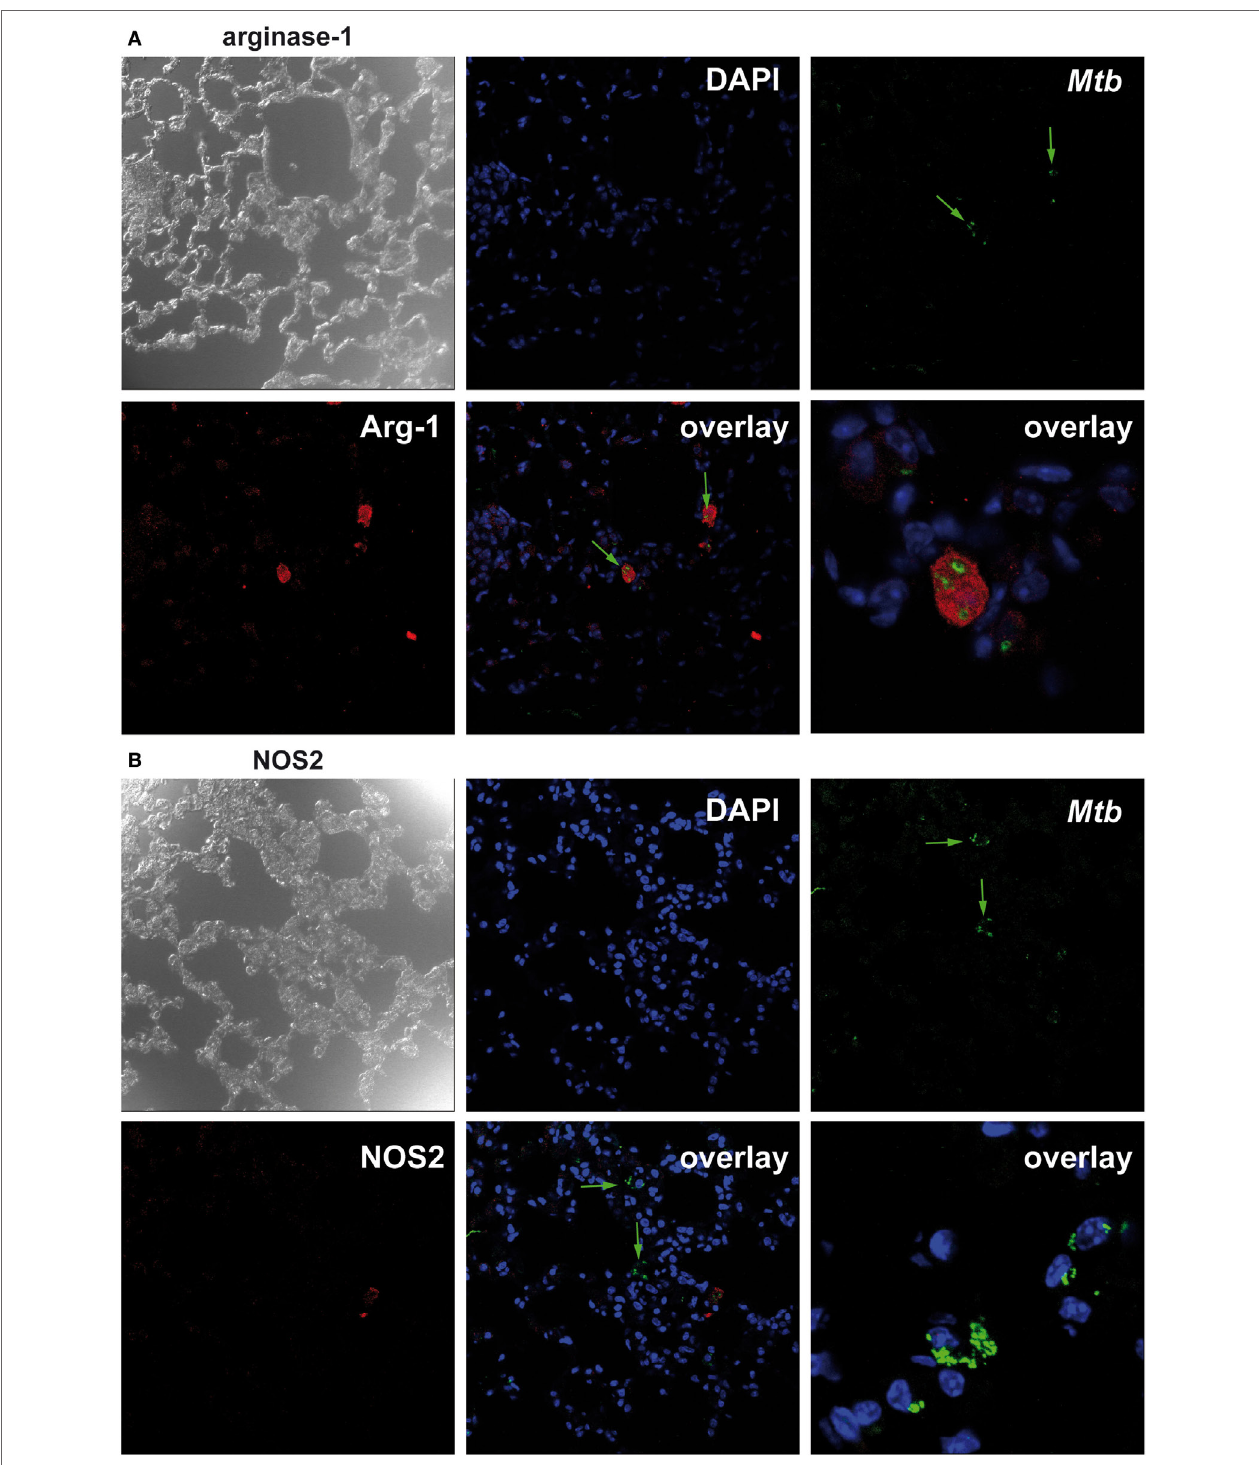
FigUre 4 | Suppressor of cytokine signaling 3 (SOCS3) deficiency in macrophages favors the initial replication of Mtb in arginase-1 (Arg1)-expressing cells. Cre-negative SOCS3 loxP/loxP control mice and LysM cre SOCS3 loxP/loxP mice were infected with approximately 1,000 CFU Mtb via the aerosol route and lungs were isolated 1 week later. After antigen retrieval and blocking, deparaffinized formalin-fixed lung sections were incubated with goat anti-Arg1 antibody or rabbit anti-NOS2 antibody. Sections were subsequently incubated with rabbit anti-goat IgG-biotin or goat anti-rabbit IgG-biotin, respectively, followed by an incubation with Streptavidin-Cy5. Finally, sections were co-stained with rabbit anti- Mtb -FITC and DAPI. Co-localization of Mtb and (a) Arg1 or (B) NOS2 was determined by confocal microscopy. Data represent representative photomicrographs of at least five mice per